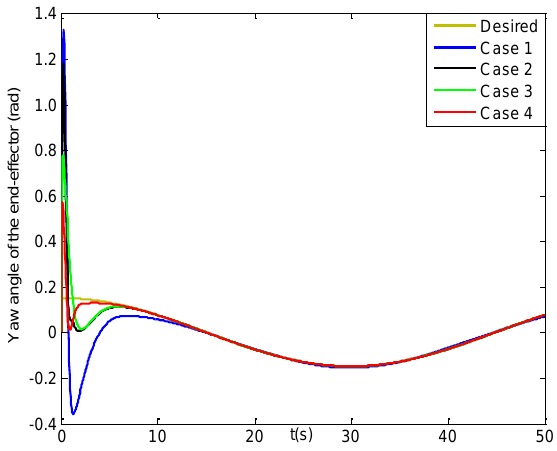
Figure 11. Yaw angles of the end − effector (four cases).